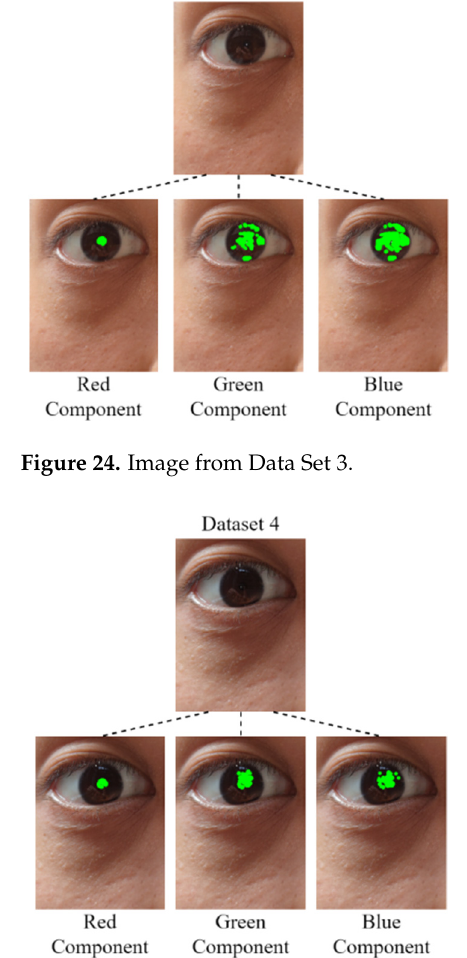
Figure 23. Image from Data Set 2.